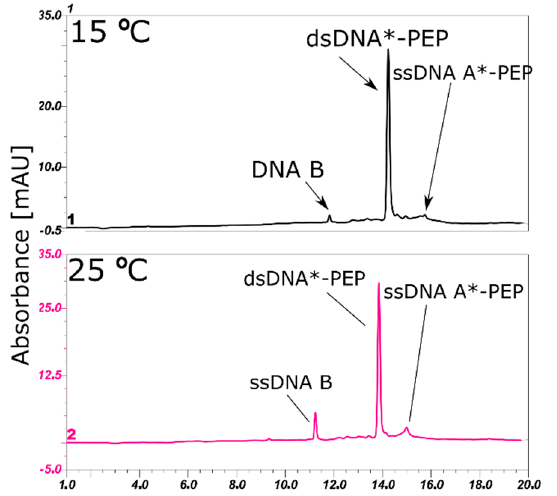
Figure 3. HPLC ( left ) and denaturative HPLC (dHPLC)—( right ) analysis of the dsDNA product obtained after annealing ssDNA peptide conjugates. Purple—non-labeled dsDNA, black—dsDNA**- PEP, blue—dsDNA*-PEP. HPLC conditions: XBridge OST reverse-phase C18 column; mobile phases A: 50 mM triethylamine acetate (TEAA) and 1% acetonitrile in water, B: 80% ACN in water; a gradient of 0–20%/20 min B was used, maintaining 1 mL/min flow rate; recorded at 260 nm. The picture clearly presents the high purity of obtained double stranded DNA systems—almost no other peaks visible.